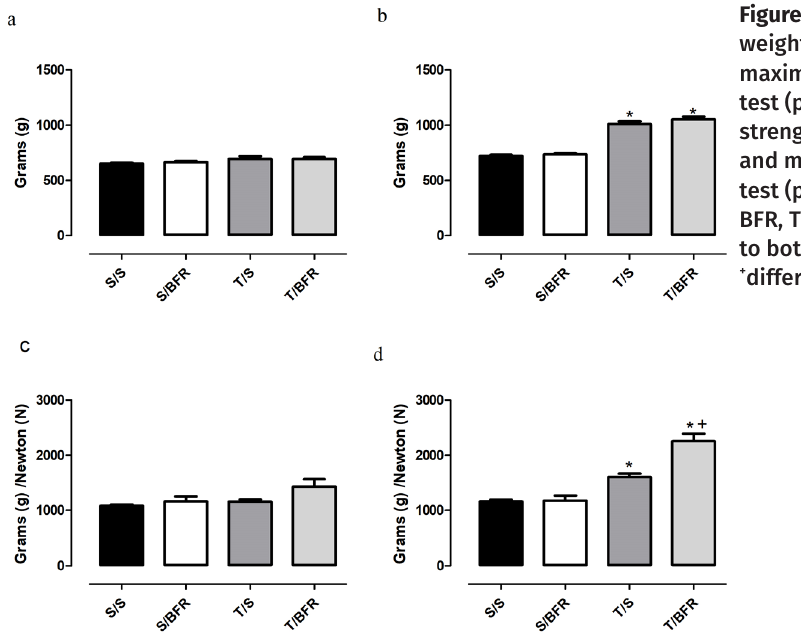
Figure 3. Maximum loaded weight initial test (panel a); maximum loaded weight final test (panel b); manual grip strength initial test (panel